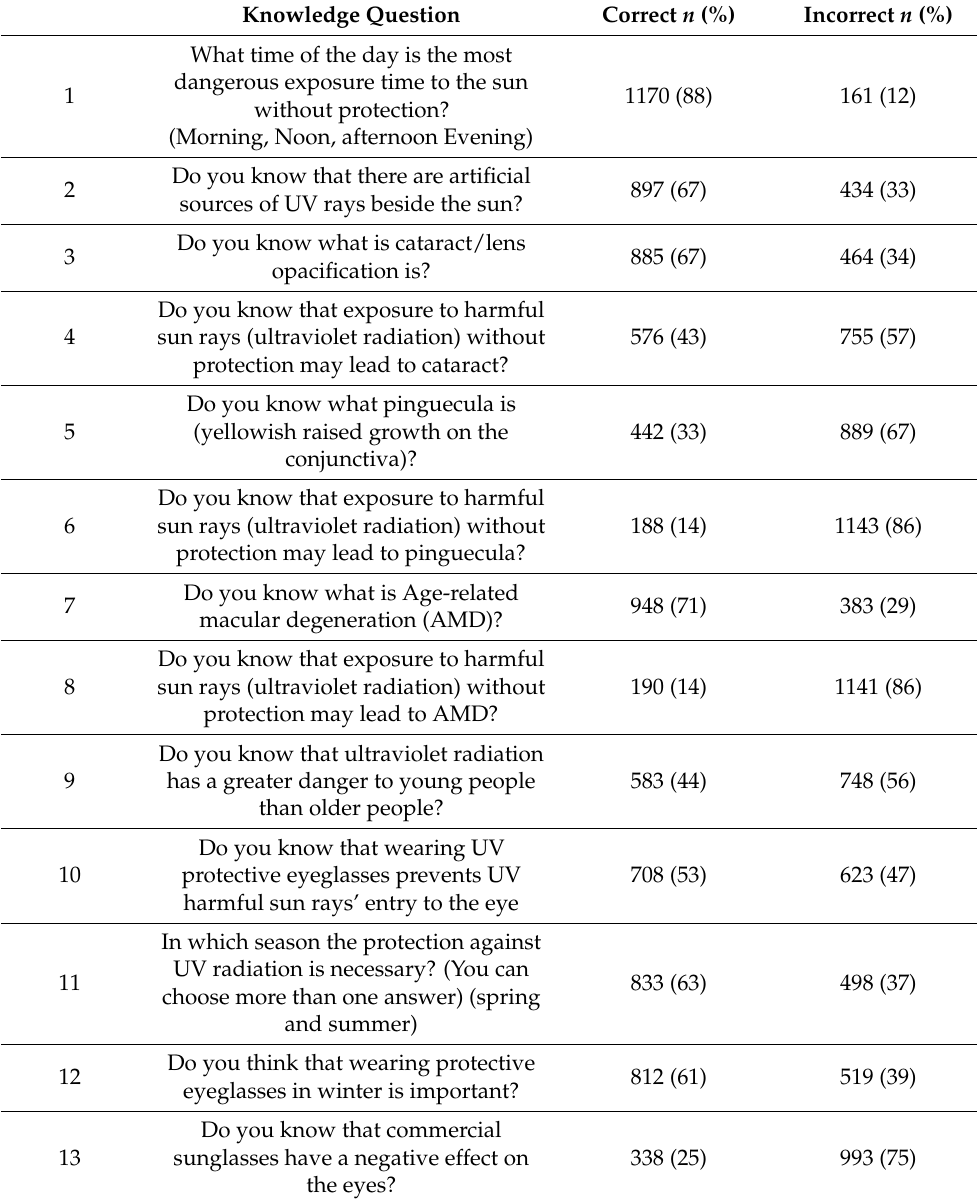
Table 3. Descriptive analysis of participants’ knowledge of UV radiation, its harm, and methods of